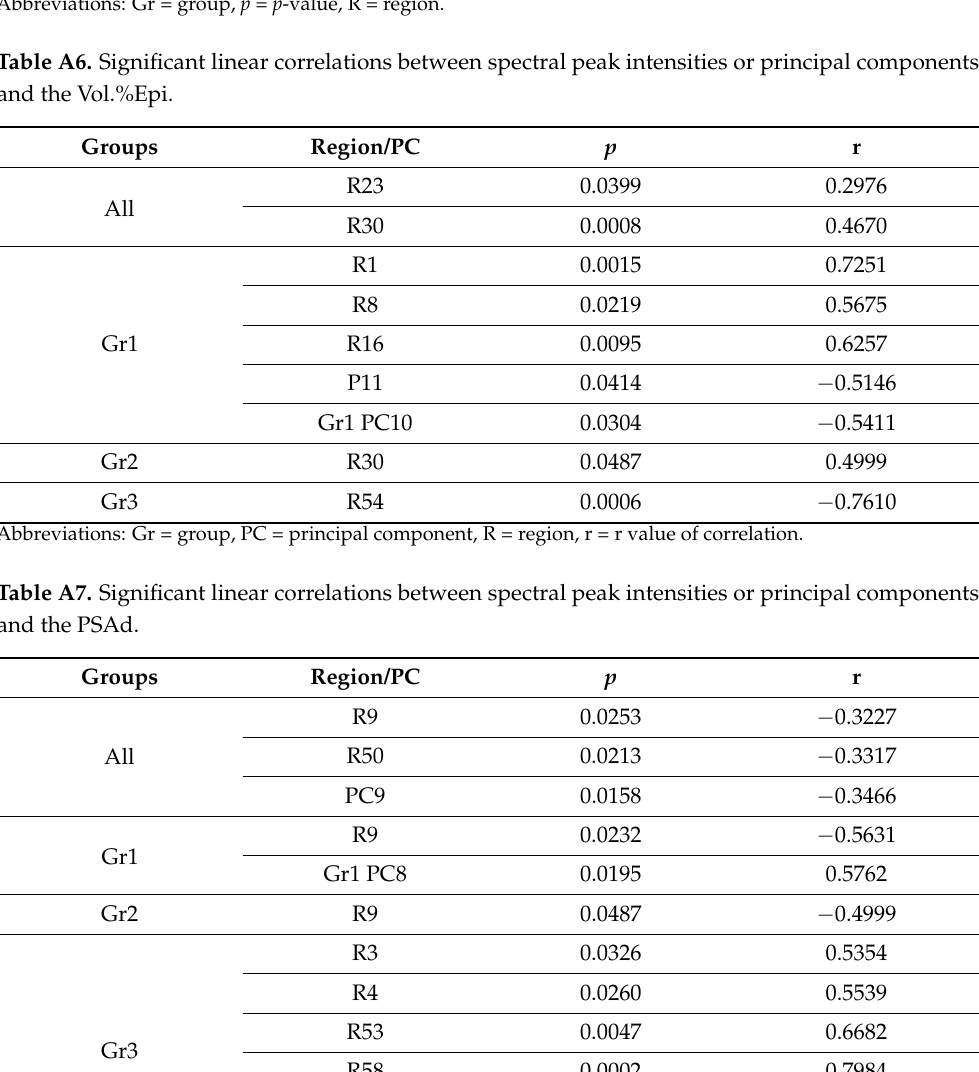
Table A5. Spectral regions with significantly different peak intensities between samples of patients with highest Gleason scores in the study period of 3 + 3 = 6 and 3 + 4 = 7. Gleason Scores Region p R23 0.048 3 + 3 = 6 & 3 + 4 = 7 R27 0.021 R28 0.013